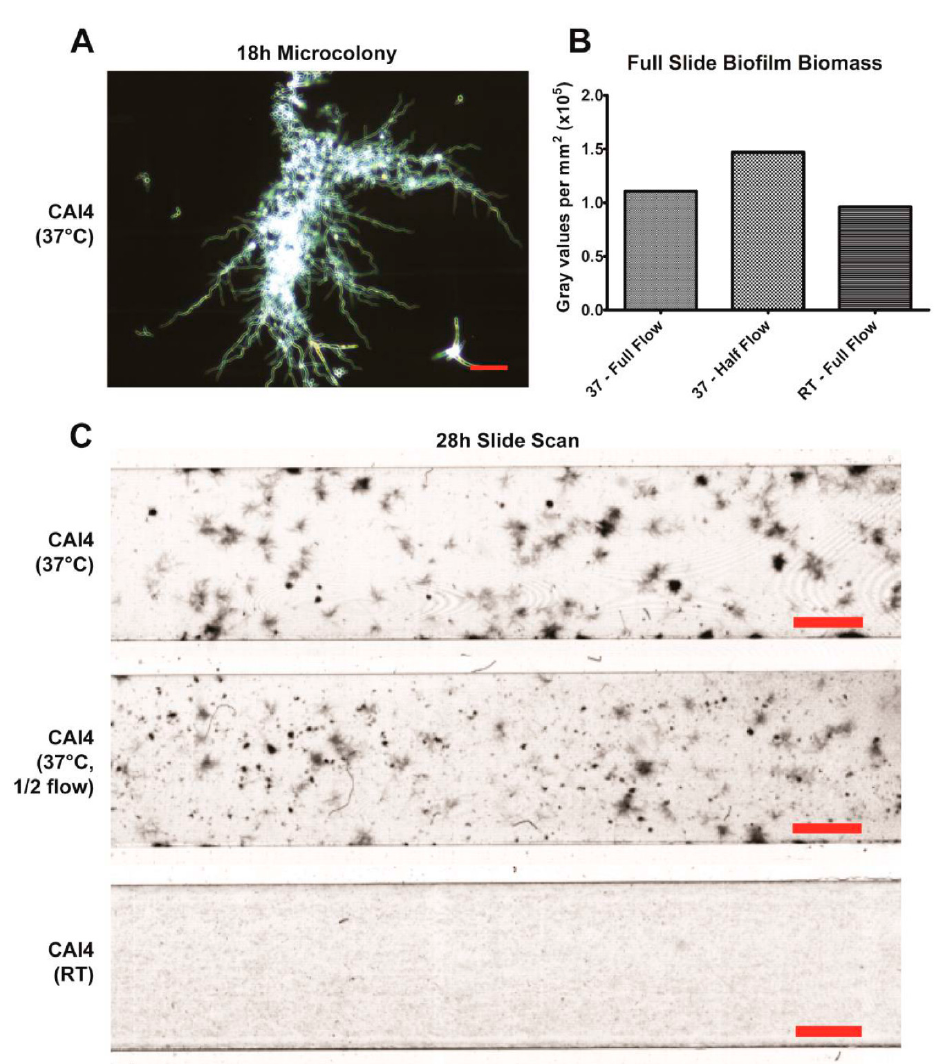
Figure 3. Formation of Microcolonies under Flow at 37 °C: ( A ) Representative image of a microcolony from a single hyphae, showing extensive hyphal branching, is shown (top left, scale bar indicates 50 µm); ( B ) Biomass comparisons between slides at 37 °C (full flow at 0.8 dynes/cm 2 , and half flow at 0.4 dynes/cm 2 ) and room temperature were done through densitometry analysis at 28 h of growth using a flatbed scanner (the heterogeneity of the 37 °C slides prevents traditional microscope analysis); ( C ) Images of scanned biofilms after 28 h of growth are shown. Scale bars indicate 2 mm.